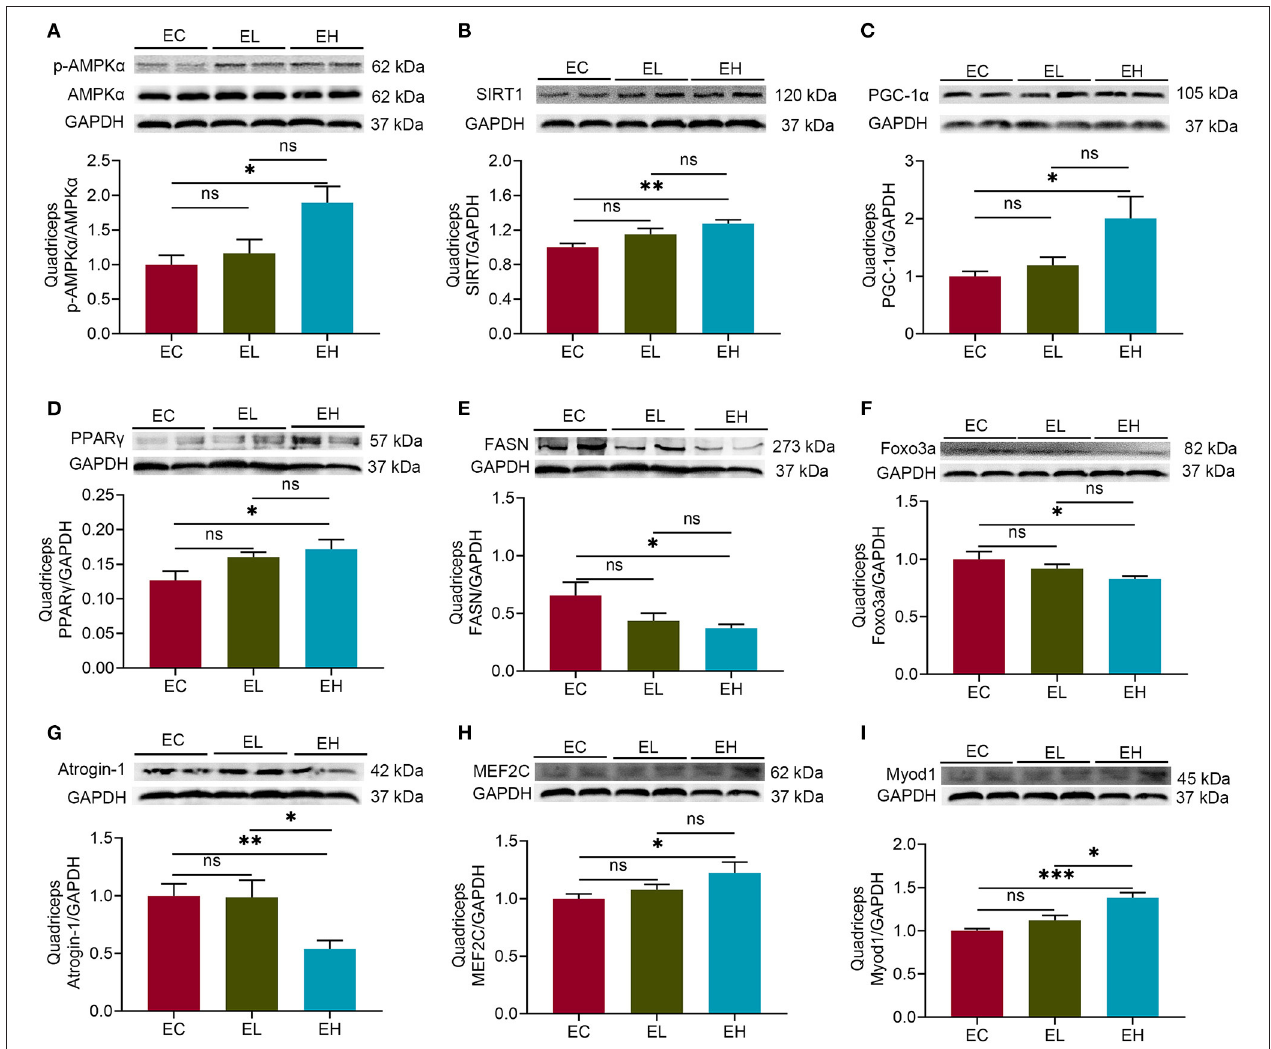
FIGURE 3 | Leucine supplementation could impact on skeletal muscle health via regulating AMPK α /SIRT1/PGC-1 α in aging mice. (A) Protein levels of p-AMPK α (thr172)/AMPK α in the endpoint groups; (B,C) the protein levels of SIRT1 and PGC-l α in the endpoint groups; (D,E) the protein levels of peroxisome proliferator-activated receptor γ (PPAR γ ) and fatty acid synthase (FASN) in the endpoint groups; (F,G) the protein levels of fork head box protein O 3a (Foxo3a) and Atrogin-1 in the endpoint groups; (H,I) the protein levels of myocyte enhancer factor-2C (MEF2C) and myogenic differentiation 1 (MyoD1) in the endpoint groups; ns, no significance; * P < 0.05; ** P < 0.01; and *** P <